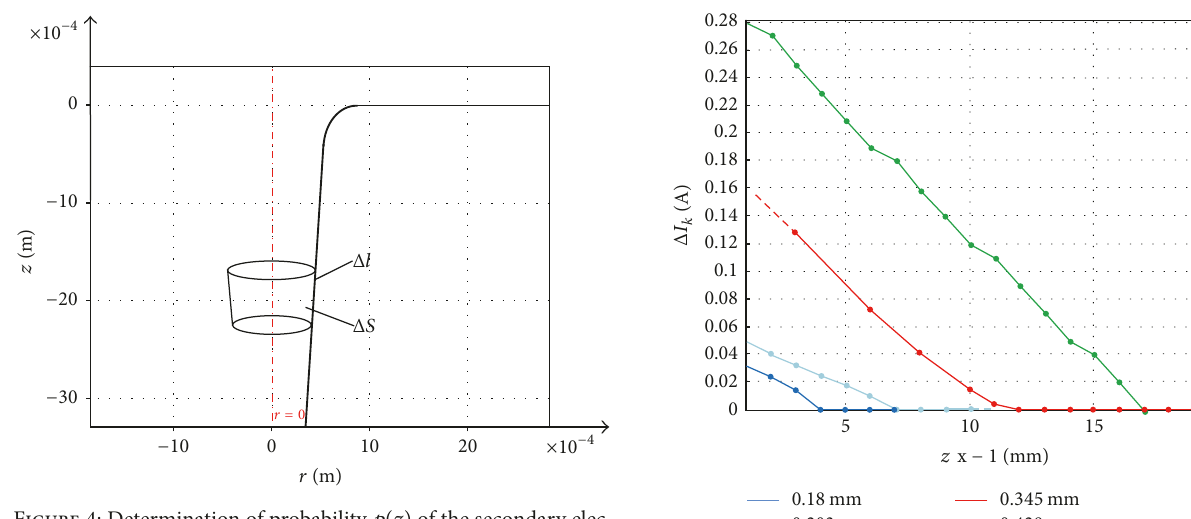
Figure 4: Determination of probability 𝑝(𝑧) of the secondary elec- trons’ passage through the penetration channel.